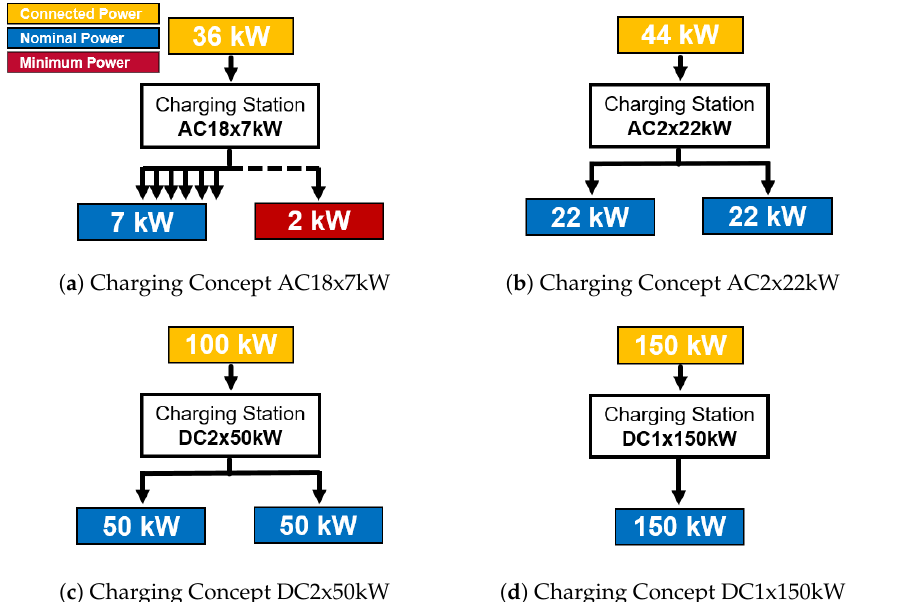
Figure 2. Considered Charging